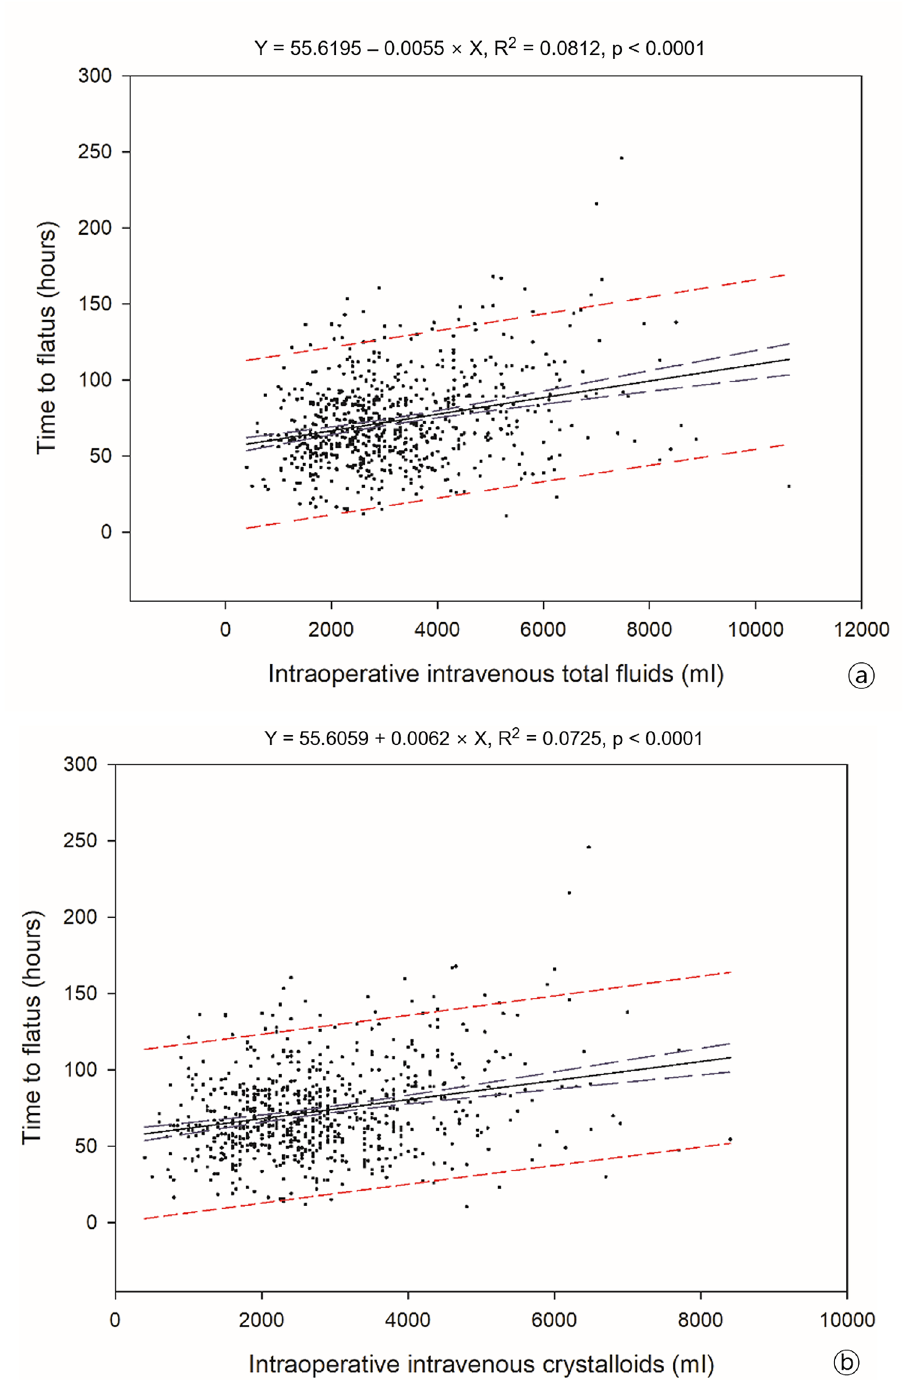
Figure 1. Linear regression analysis of the associations between intraoperative intravenous fluids and the postoperative ileus period as time to flatus; ( a ) total fluids, ( b ) crystalloid (blue long dash line—95% confidence band, red short dash line—95% prediction